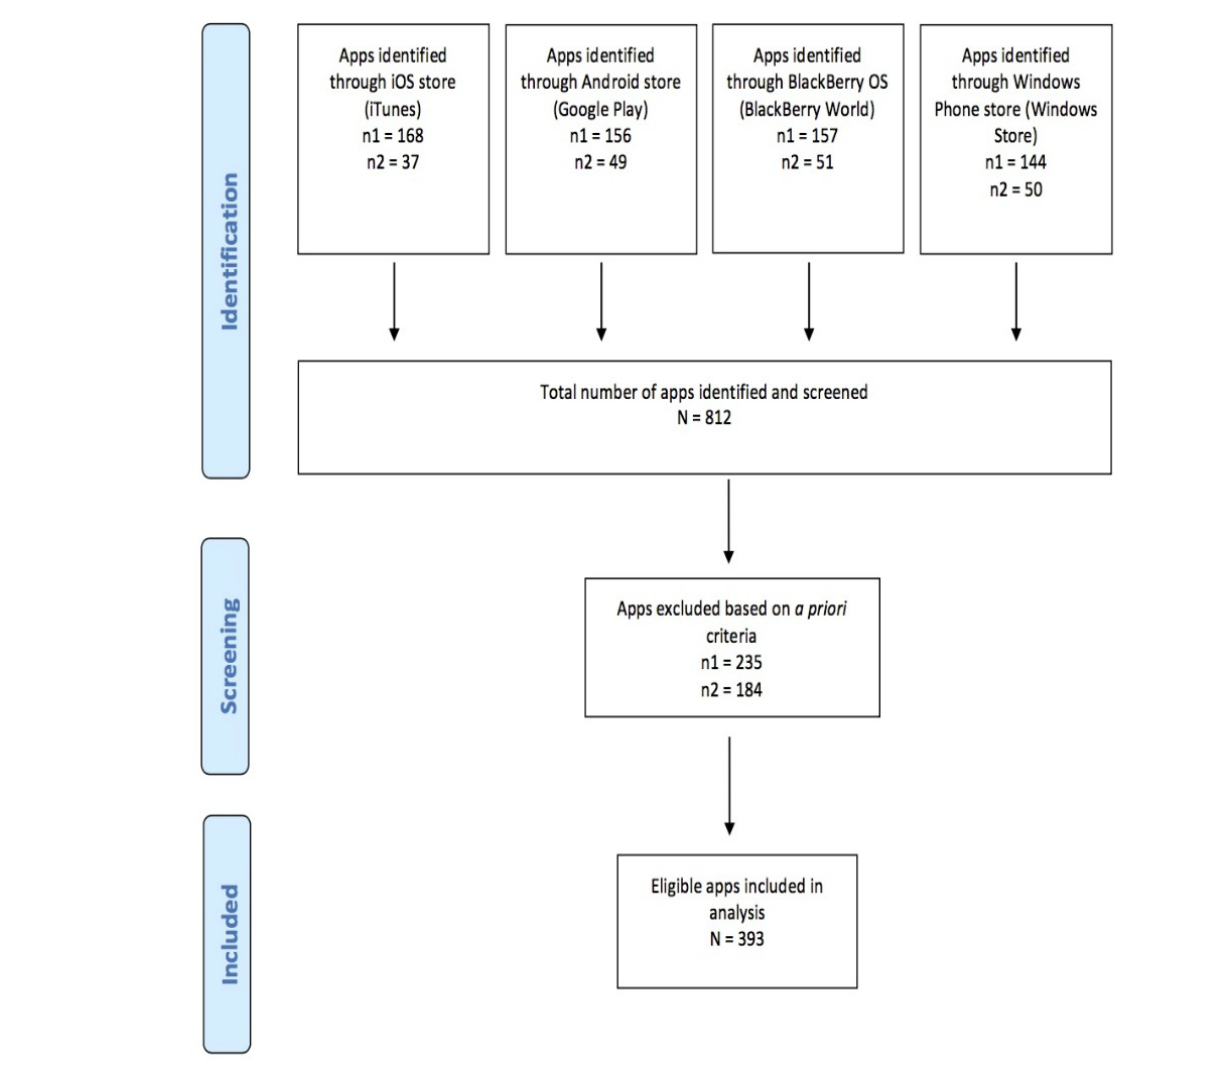
Figure 1. Flow diagram of study